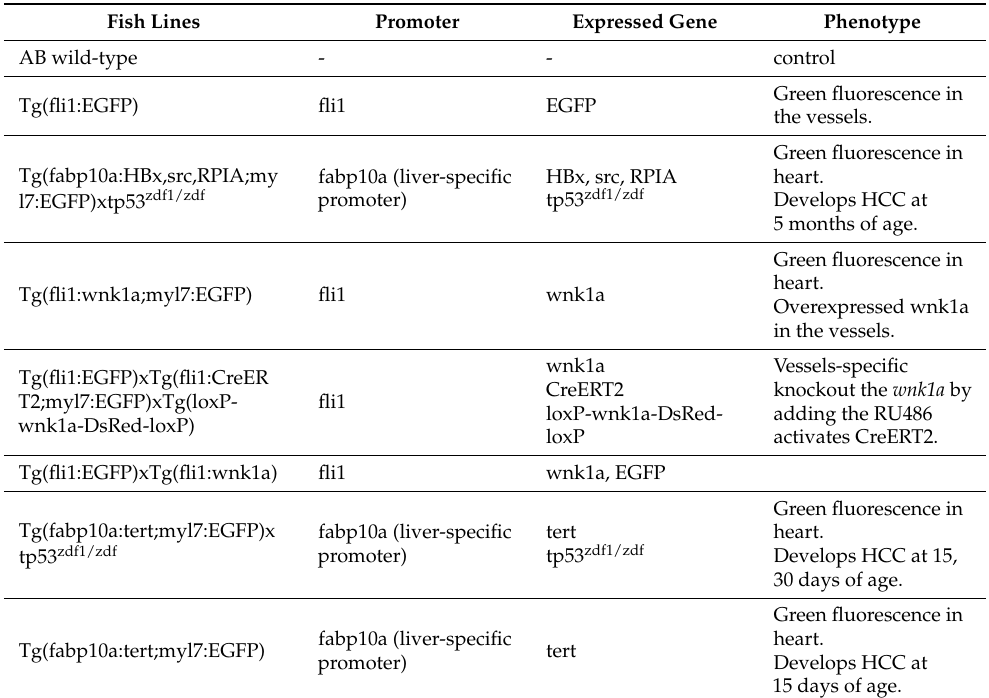
Table 1. Table 1. Transgenic fish lines used in this